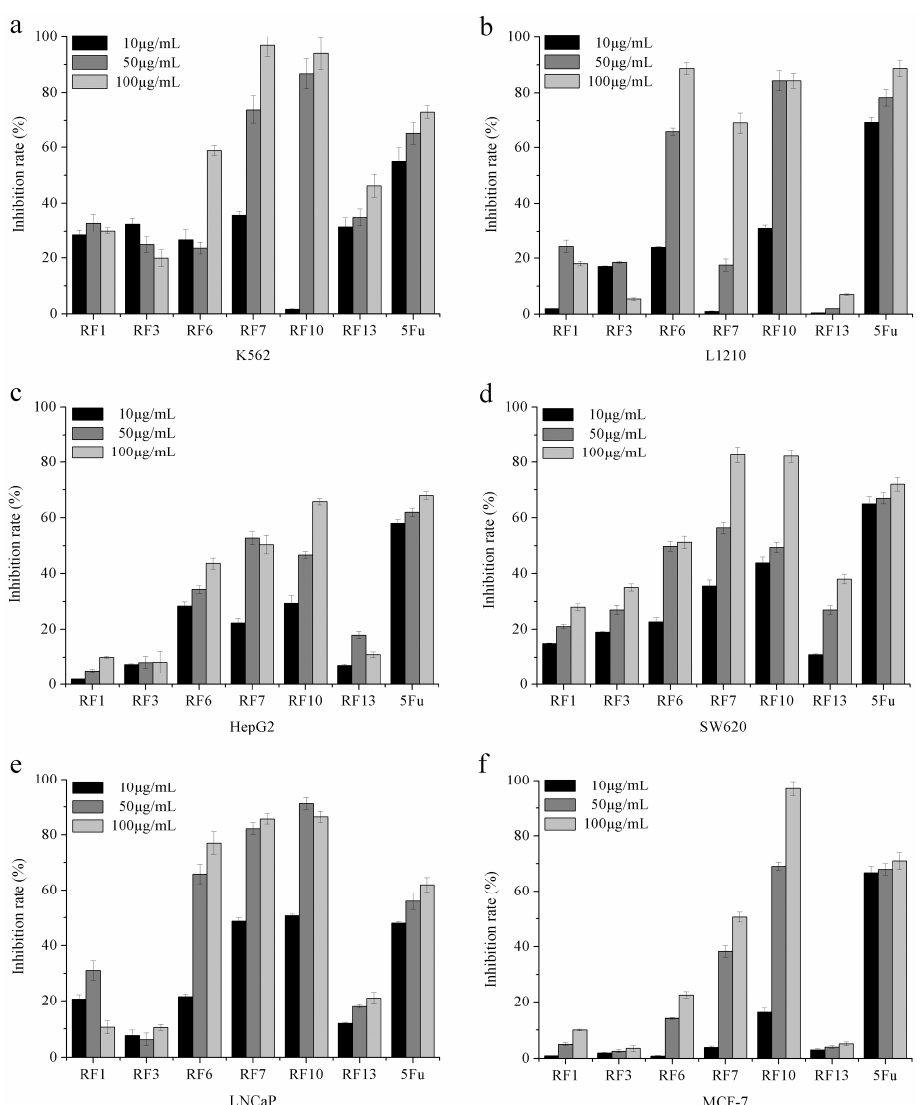
Figure 4. Inhibitory effects of compounds at different concentrations on various tumor cell lines in vitro. ( a ) K562 cells; ( b ) L1210 cells; ( c ) HepG2 cells; ( d ) SW620 cells; ( e ) LNCaP cells; ( f ) MCF-7 cells. 5Fu served as a positive control.RF1 is ergosterol; RF3 is ergosta-7,22-dien-3 β -yl pentadecanoate; RF6 is 3,4-dihydroxy benzaldehyde; RF7 is inoscavin A; RF10 is baicalein; RF13 is 24-ethylcholesta-5,22-dien-3 β -ol.